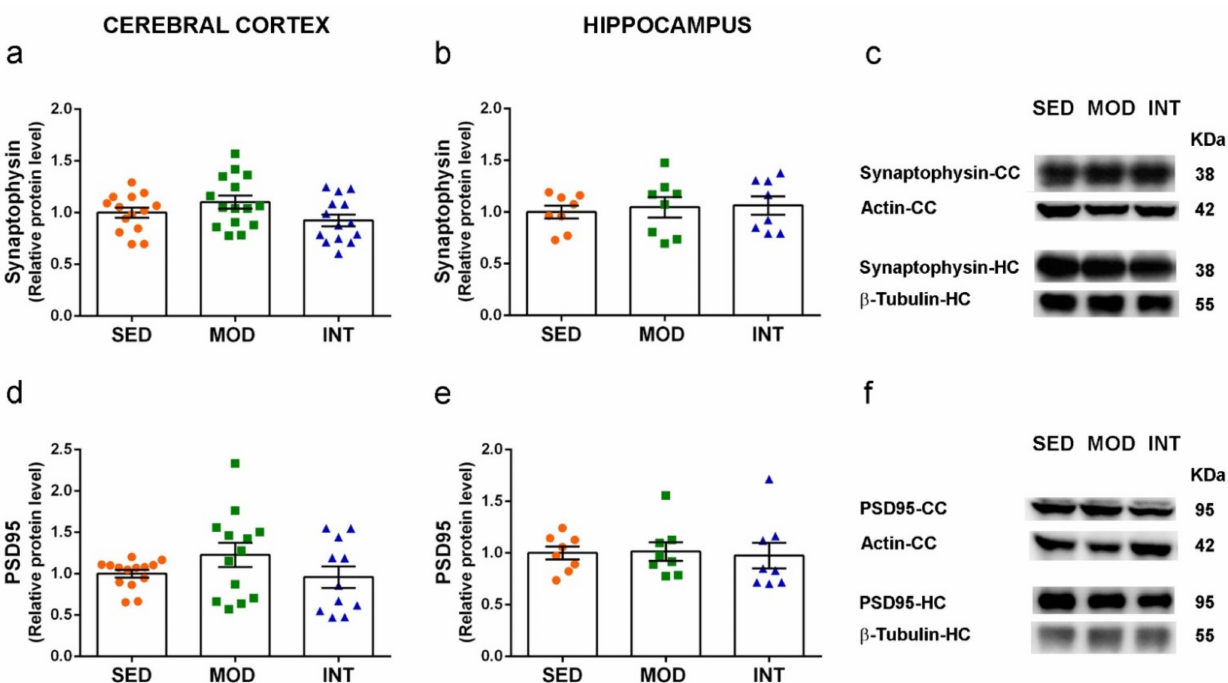
Figure 6. Synaptic markers synaptophysin and PSD95 were not modified by exercise in young mice. ( a – c ) Levels of synaptophysin in the cerebral cortex (CC) and hippocampus (HC), as indicated, and representative blots of experimental groups; ( d – f ) levels of PSD95 in cerebral cortex and hippocampus and representative blots. Experimental groups: SED (orange circles), sedentary; MOD (green squares), moderate training; INT (blue triangles), high-intensity training. Values are mean ± SEM (( a ) SED n = 14, MOD n = 15, INT n = 14; ( b , e ) SED n = 8, MOD n = 8, INT n = 8; ( d ) SED n = 14, MOD n = 13, INT n =